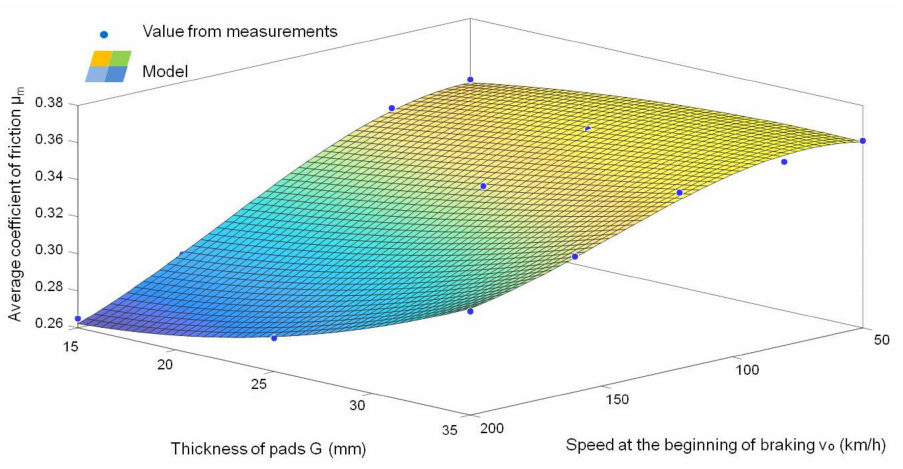
Figure 10. Dependence of the average coefficient of friction µ m on the braking speed for N = 25 kN, M = 5.7 t and three friction lining